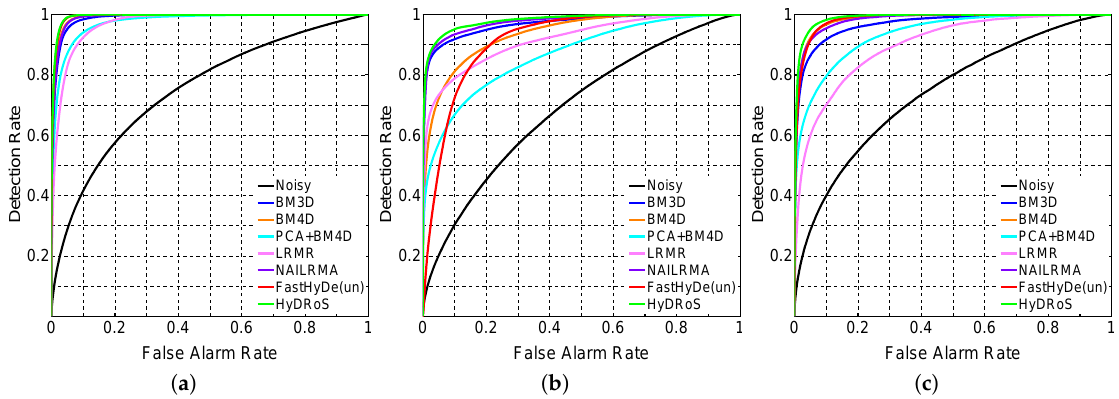
Figure 8. ROC curves for the three minerals obtained by SAM: ( a ) Alunite; ( b ) Chalcedony; ( c ) Kaolinite.